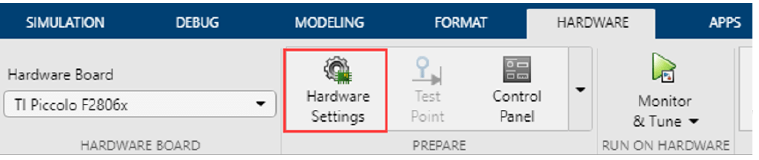
Figure 5. Simulink Hardware configuration window.